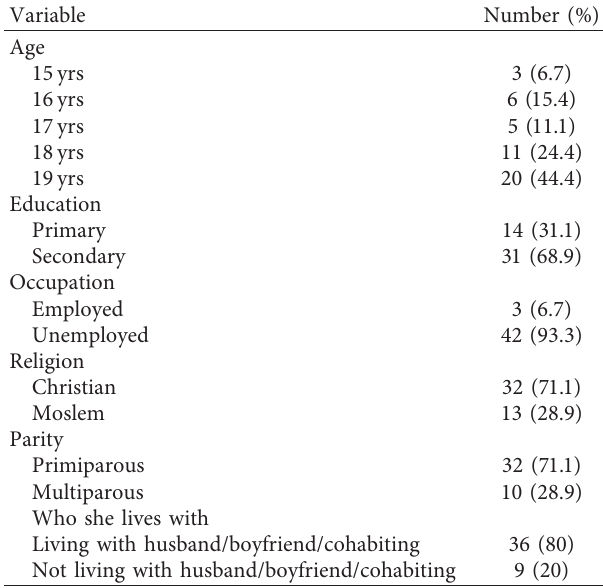
Table 1: Characteristics of